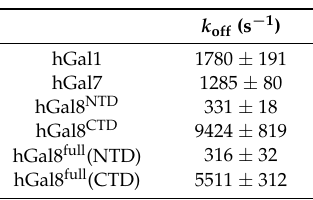
Table 2. Lactose dissociation rate ( k off ) of hGal1, hGal7, hGal8 NTD and hGal8 CTD determined by lineshape analysis of 2D 15 N- 1 H HSQC spectra.